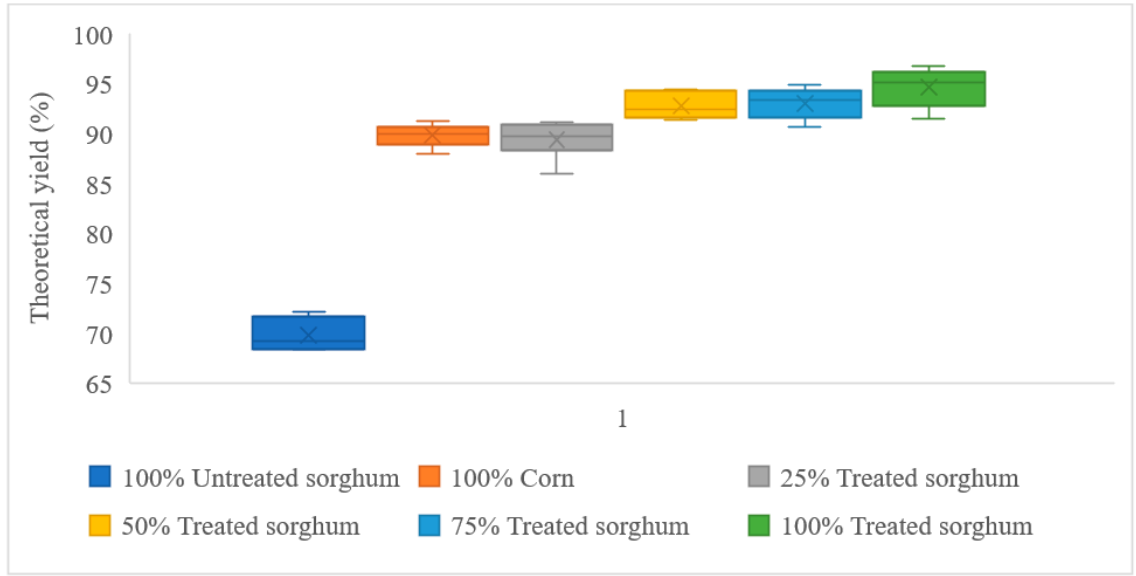
Figure 3. Theoretical yield of fermentations with cellulase. Comparison of the trials with and without added cellulase indicated that cellulase